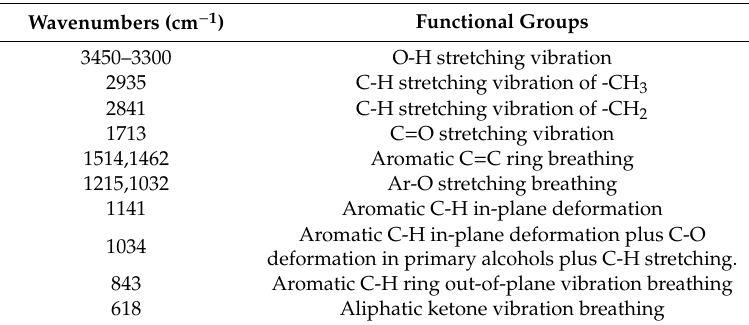
Table 1. Functional group structure of bio-oil sample.